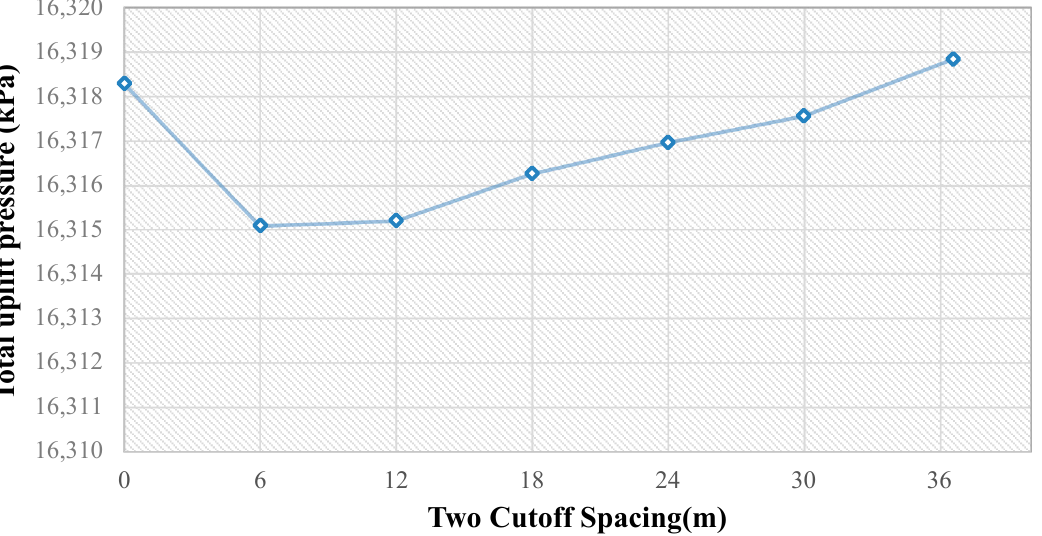
Figure 13. Uplift pressure under the core for different cutoff spacing.